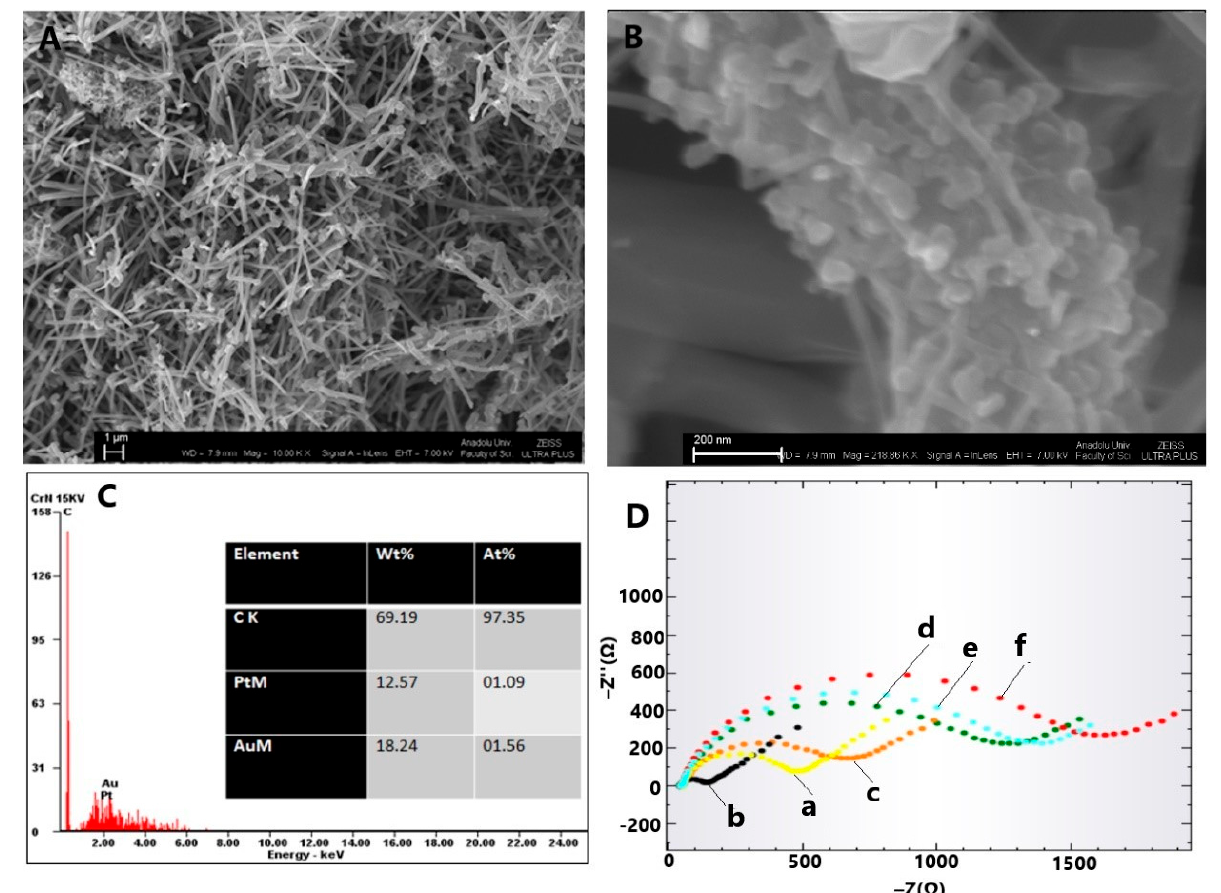
Figure 2. SEM images of the MWCNT-Au-Pt hybrid nanomaterial at ( A ). 1000× magnification, ( B ). 21886× magnification, ( C ). EDX spectrum of the MWCNT-Au-Pt hybrid nanomaterial and ( D ). Nyquist plots of the developed immunosensor for electrochemical characterization (a. AuSPE, b. MWCNT-Au-Pt/AuSPE, c. Cysteamine/MWCNT-Au-Pt/AuSPE, d. Anti-H1/cysteamine/MWCNT-Au-Pt/AuSPE e. BSA/anti-H1/cysteamine/MWCNT-Au-Pt/AuSPE, f. H1N1 virus/BSA/anti-H1/cys- teamine/MWCNT-Au-Pt/AuSPE).